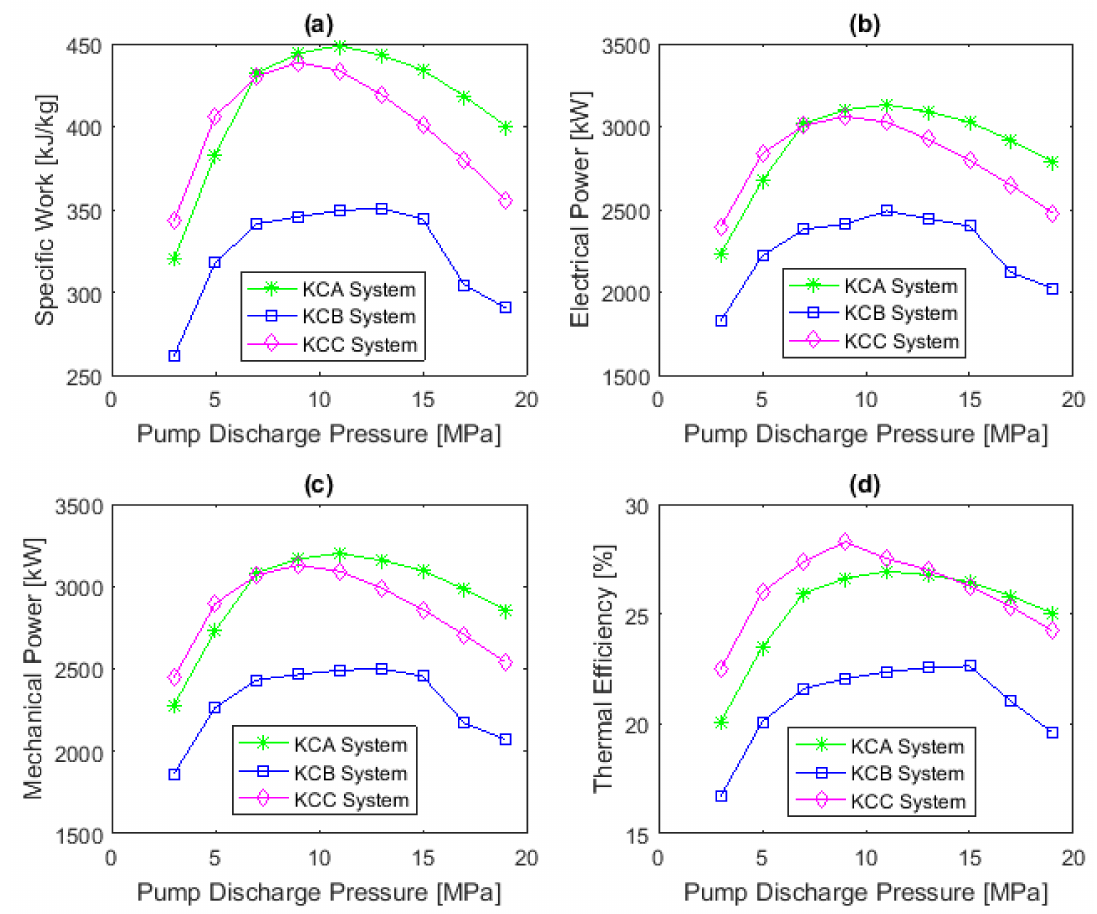
Figure 7. Effect of pump discharge pressure on the: ( a ) specific performance, ( b ) electrical power, ( c ) mechanical power, and ( d ) thermal